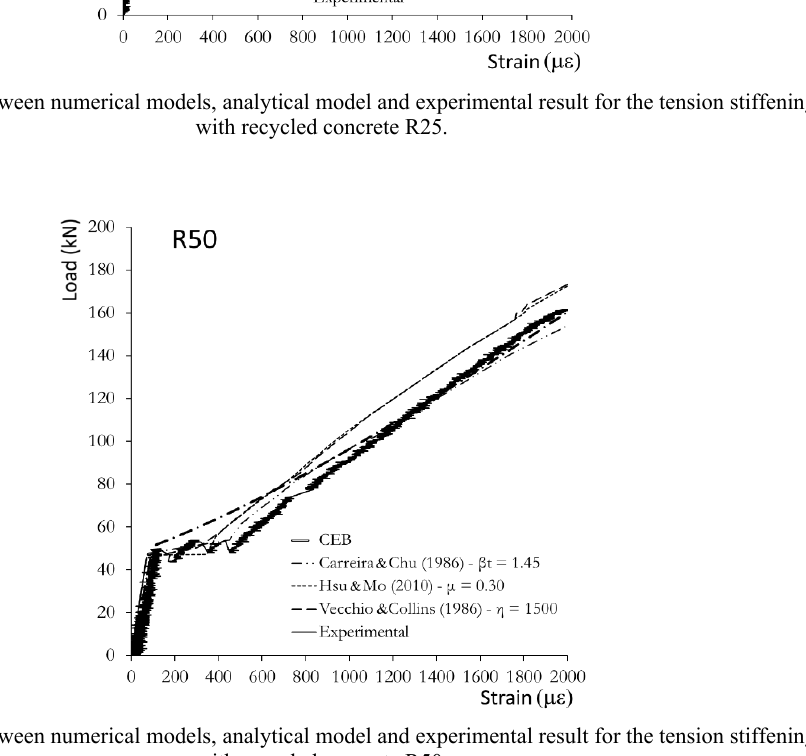
Figure 13. Comparison between numerical models, analytical model and experimental result for the tension stiffening element with recycled concrete